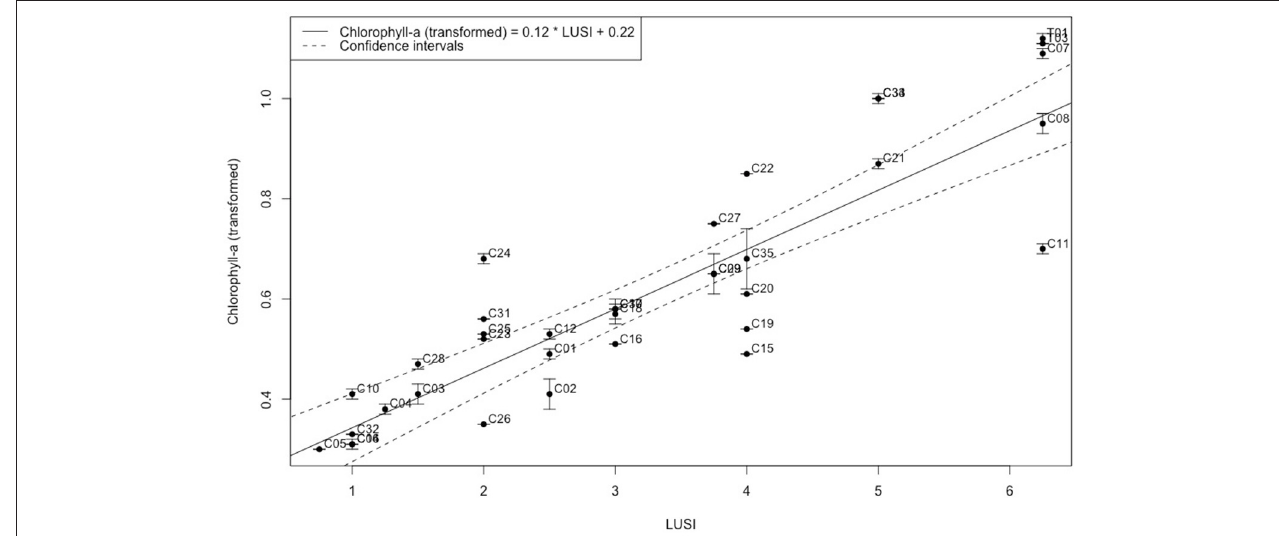
FIGURE 4 | Pressure-impact relationship between LUSI values calculated using the 2009 Mapa de Cobertes del Sòl de Catalunya and chlorophyll- a concentrations ( µ g/L) for the water bodies of the Catalan coast ( R 2 value = 0.82 and p -value = 8.14 × 10 − 8 ). Chlorophyll- a was measured between 2007 and 2012; circles represent the means, and error bars the standard deviations of the log-transformed 90th percentiles. Chlorophyll- a confidence intervals of the relationship and the codes of the water bodies are shown. See the text for details on the